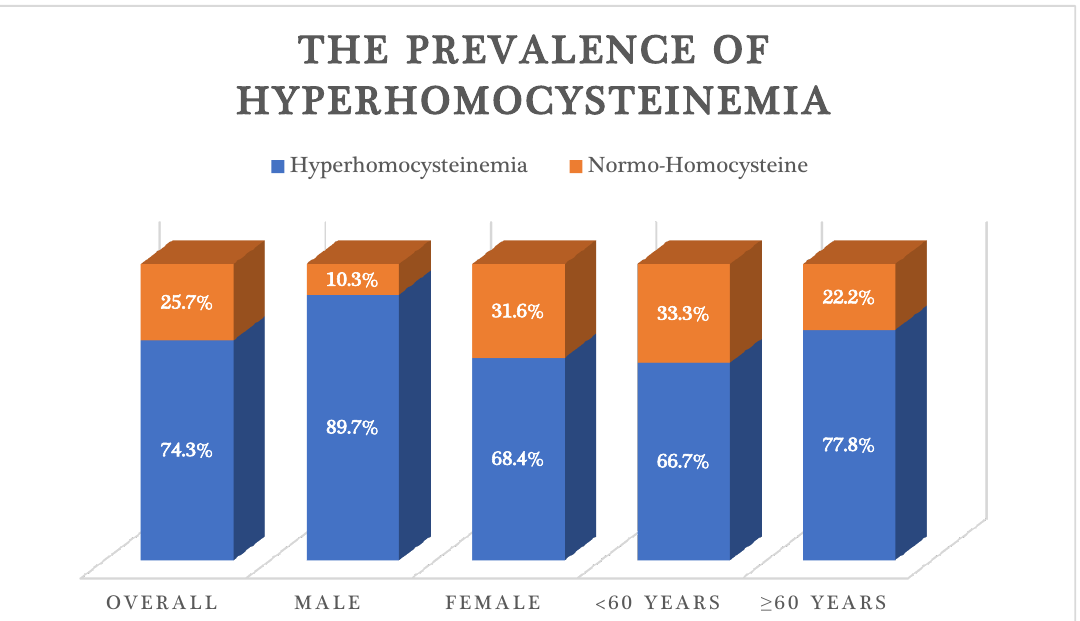
Figure 2. The prevalence of hyperhomocysteinemia in patients with primary hypertension be gender and age group.